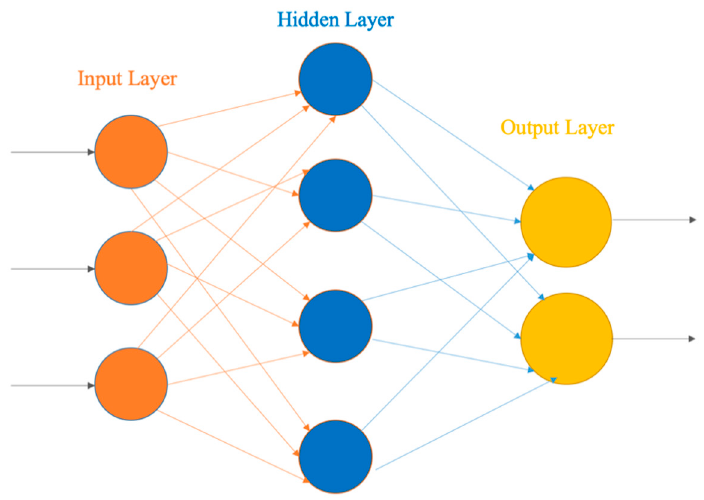
Figure 8. Artificial neural network (ANN) structure.